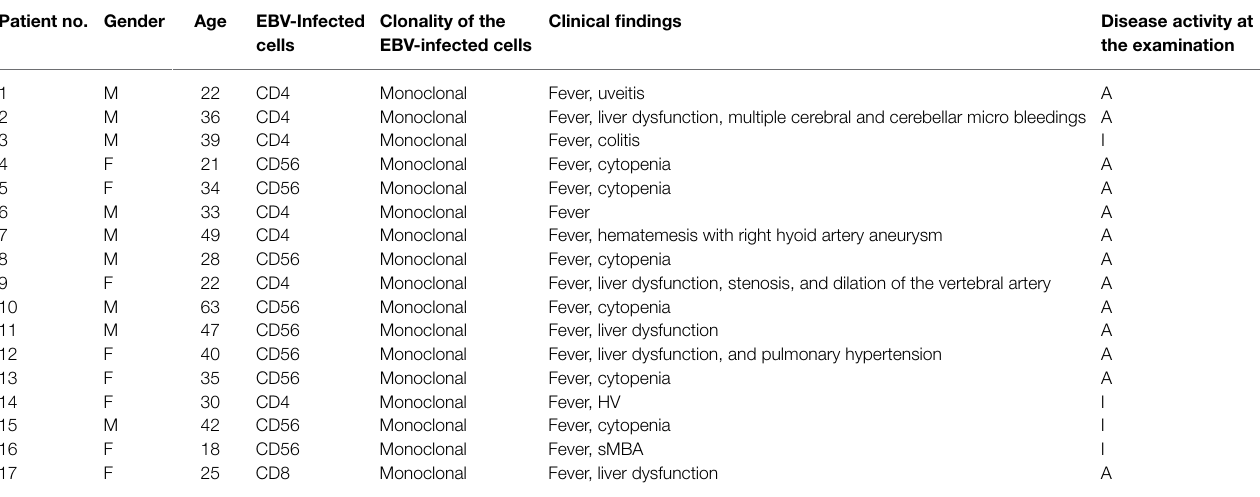
TABLE 1 | Patient